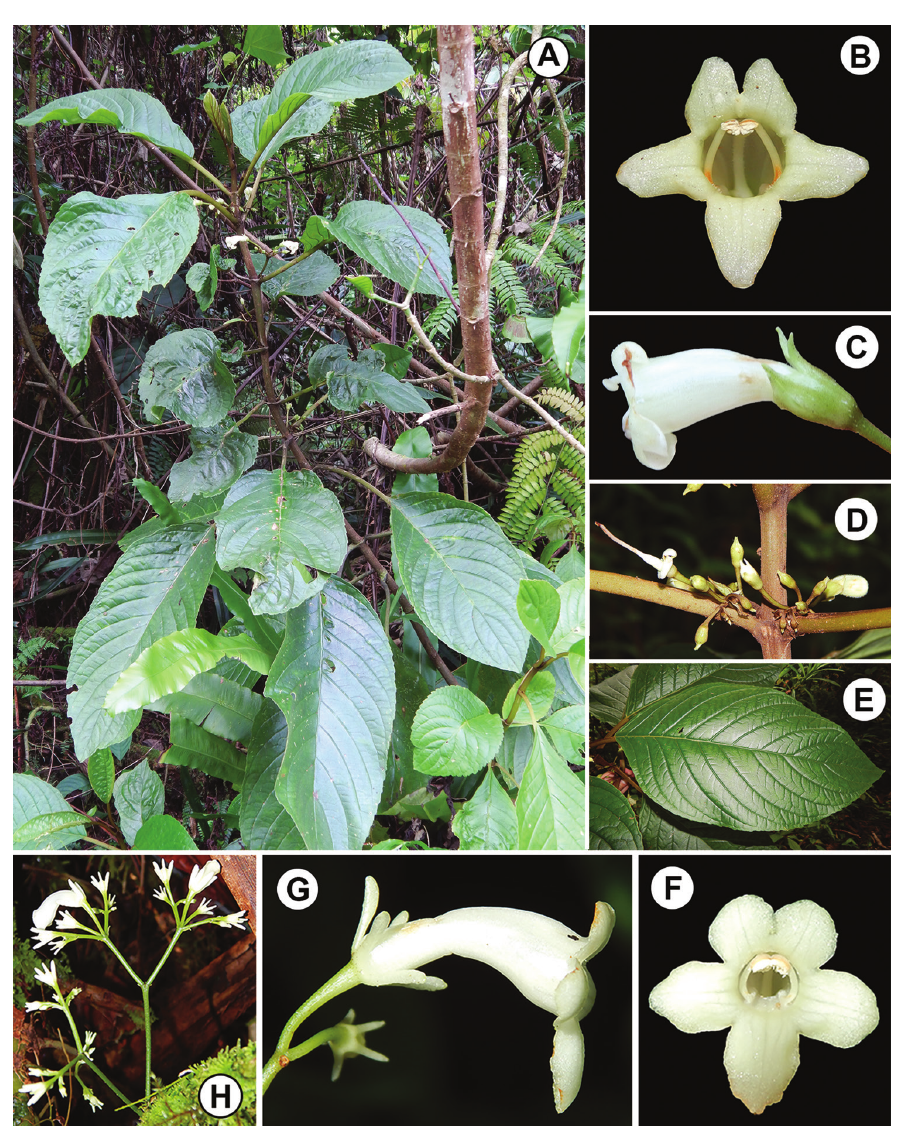
Figure 2. Cyrtandra gregoryi M.A.Johnson and closest relative ( C. ciliata ) based on a molecular phylog- eny by Johnson et al. (2017). A C. gregoryi shrub habit B C. gregoryi corolla, anterior view C C. gregoryi flower, lateral view D C. gregoryi axillary cyme inflorescence E C. gregoryi adaxial leaf surface F C. ciliata corolla, anterior view G C. ciliata flower, lateral view H C. ciliata cauliflorous cyme inflorescence. All photos taken in the field by M.